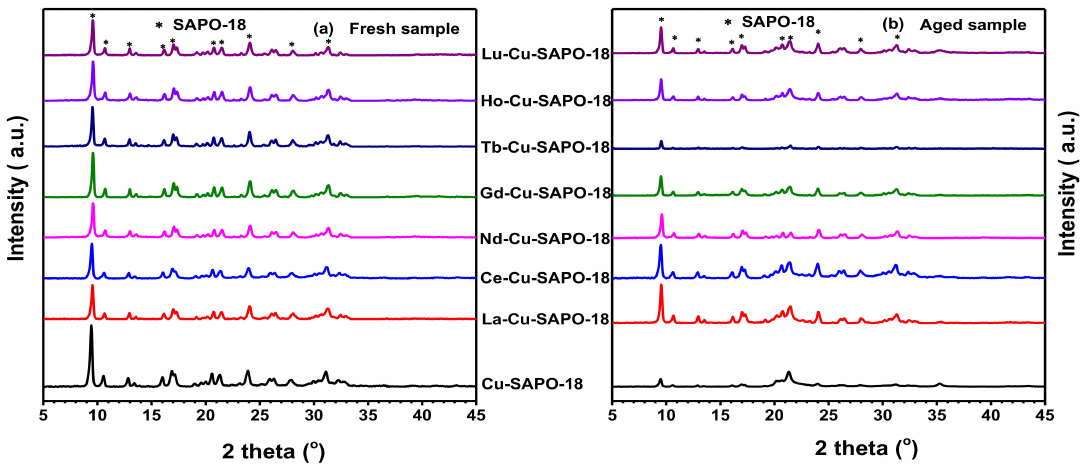
Figure 5. XRD patterns of the ( a ) fresh and ( b ) hydrothermally aged Cu-SAPO-18 and M-Cu-SAPO-18 samples.